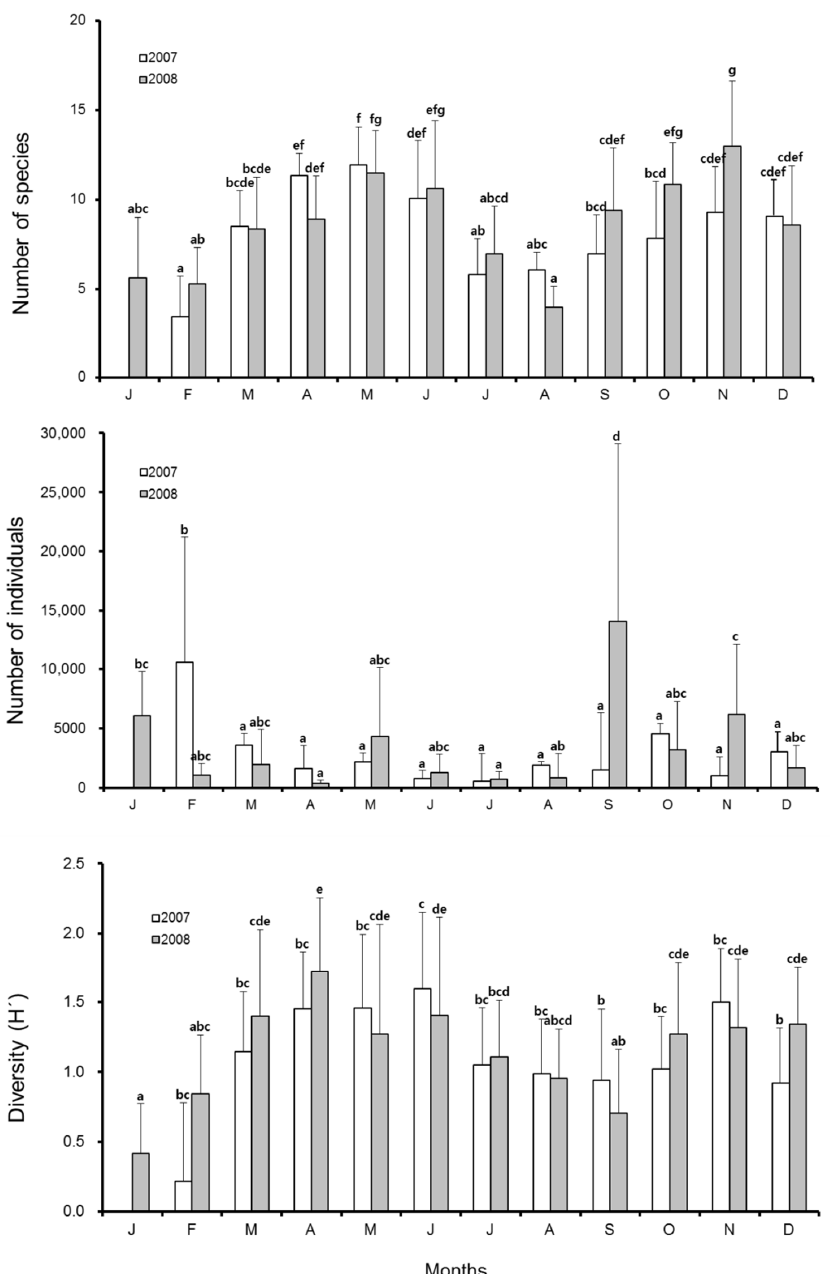
Figure 4. Monthly variations in the number of species, the number of individuals, and the diversity (H’) of fishes captured in set nets in the Yangyang coastal areas from February 2007 to December 2008. The significance of the differences was assessed by one-way ANOVA followed by a Tukey’s test. Different letters above each error bar indicate statistically significant differences compared to control conditions at p < 0.05.